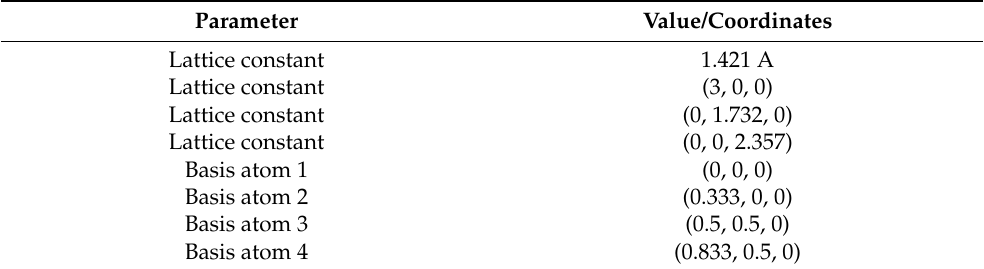
Table 1. Parameters of Tersoff potential used in MD simulations.